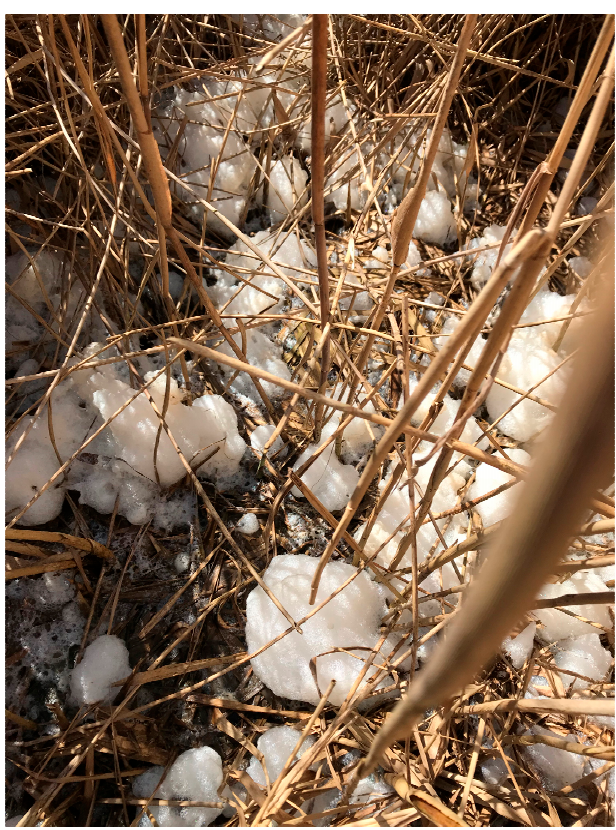
Figure 3. Microbial stress response in a nutrient-limited wetland, producing a characteristic foam.